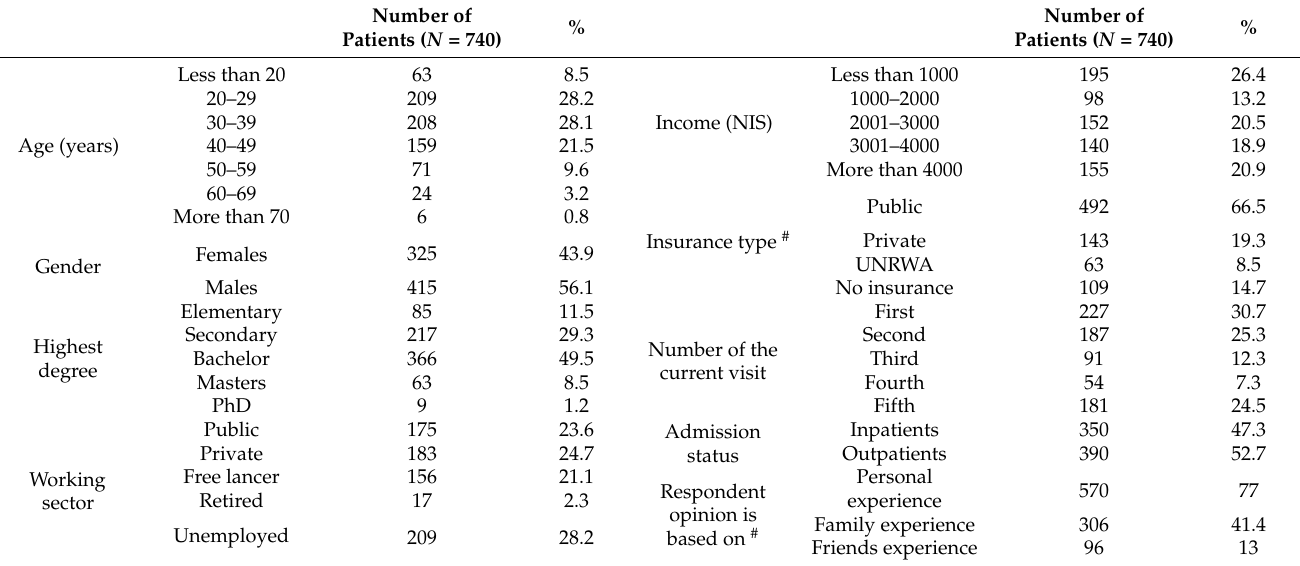
Table 2. Characteristics and sociodemographics of respondents (patients).